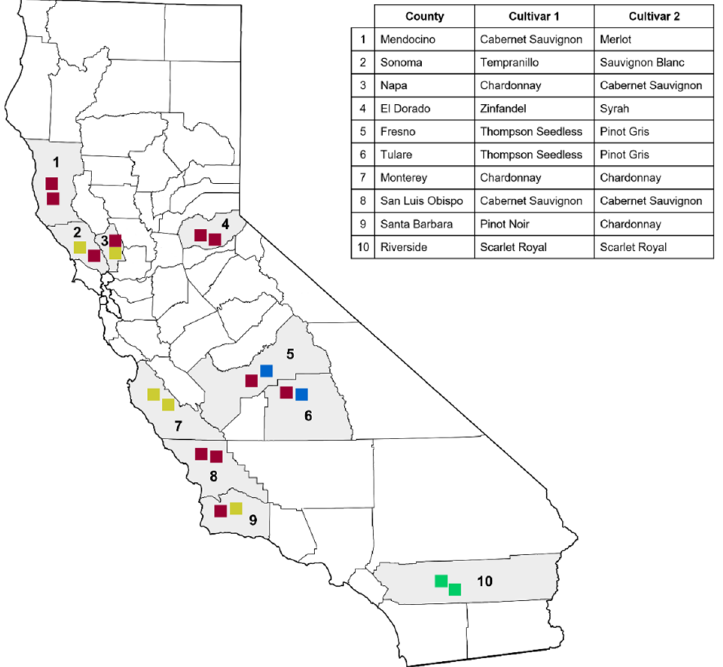
Figure 1. Sampled vineyards across California showing counties, type of vineyard (in colored squares) and cultivars. Red squares = red wine, yellow squares = white wine, blue squares = raisin, green squares = table grape.